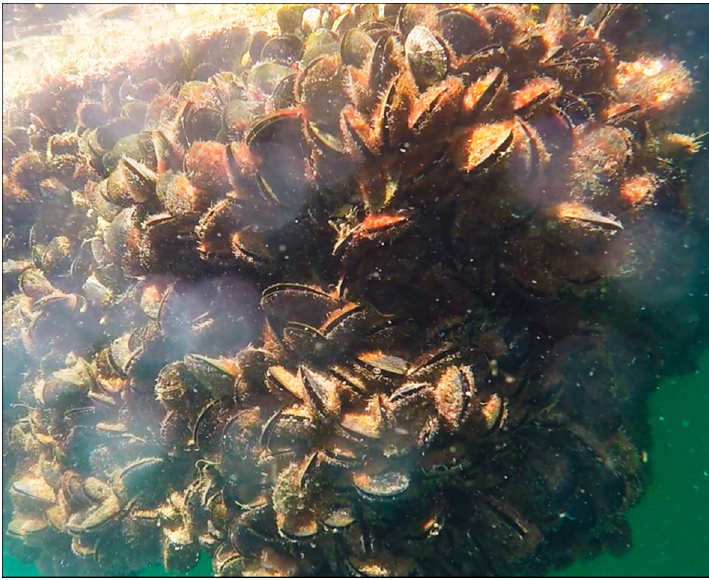
Figure 4. Dense assemblage of mussels ( Mytilus galloprovincialis ) growing under a marina walkway. Life Cycle